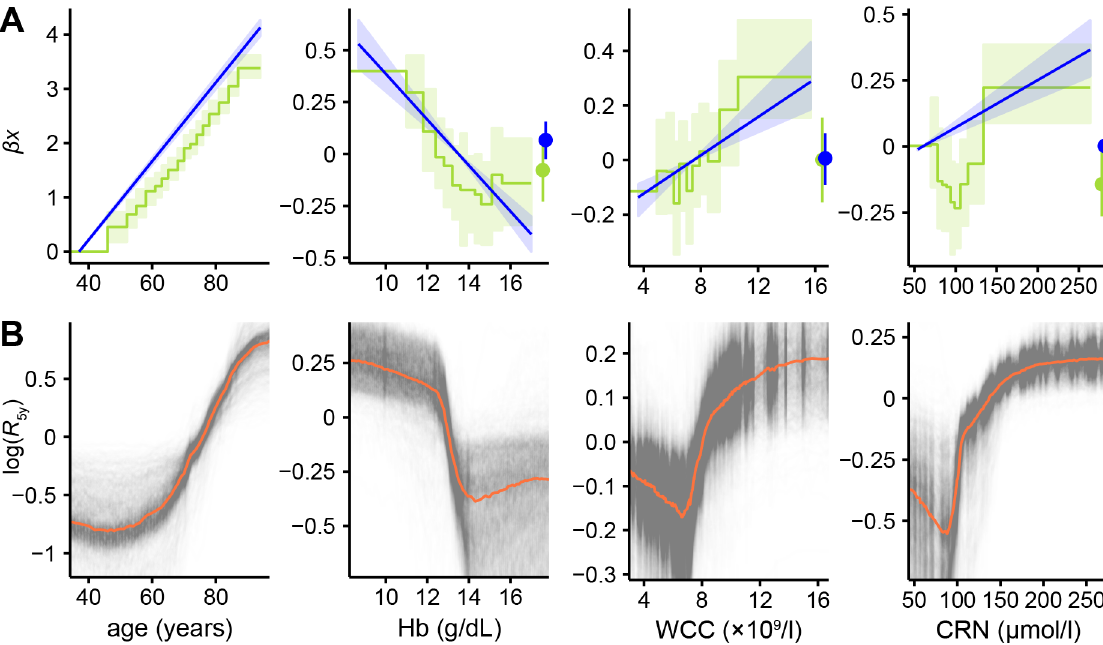
Fig 4. Variable effect plots from Cox models and partial dependence plots for random survival forests. (A) Comparisons between relative log-risks derived from the continuous Cox models (straight blue lines, light blue 95% CI region) against those derived from the discretised models (green steps, light green 95% CI region), together with log-risks associated with those values being missing (points with error bars on the right of plots). Confidence intervals on the continuous models represent Δ β i x i for each variable x i , and hence increase from the value taken as the baseline where x = 0. The lowest-valued bin of the discrete Cox model is taken to be the baseline and has no associated i uncertainty. Discrete model lines are shifted on the y -axis to align their baseline values with the corresponding value in the continuous model to aid comparison; since these are relative risks, vertical alignment is arbitrary. (B) Partial dependence plots [46] inferred from random forests. Semitransparent black lines show the change in log-risk of death after five years from sweeping across possible values of the variable of interest whilst holding other variables constant. Results are normalised to average mortality across all values of this variable. Thick orange lines show the median of the 1000 replicates, indicating the average response in log-risk to changing this